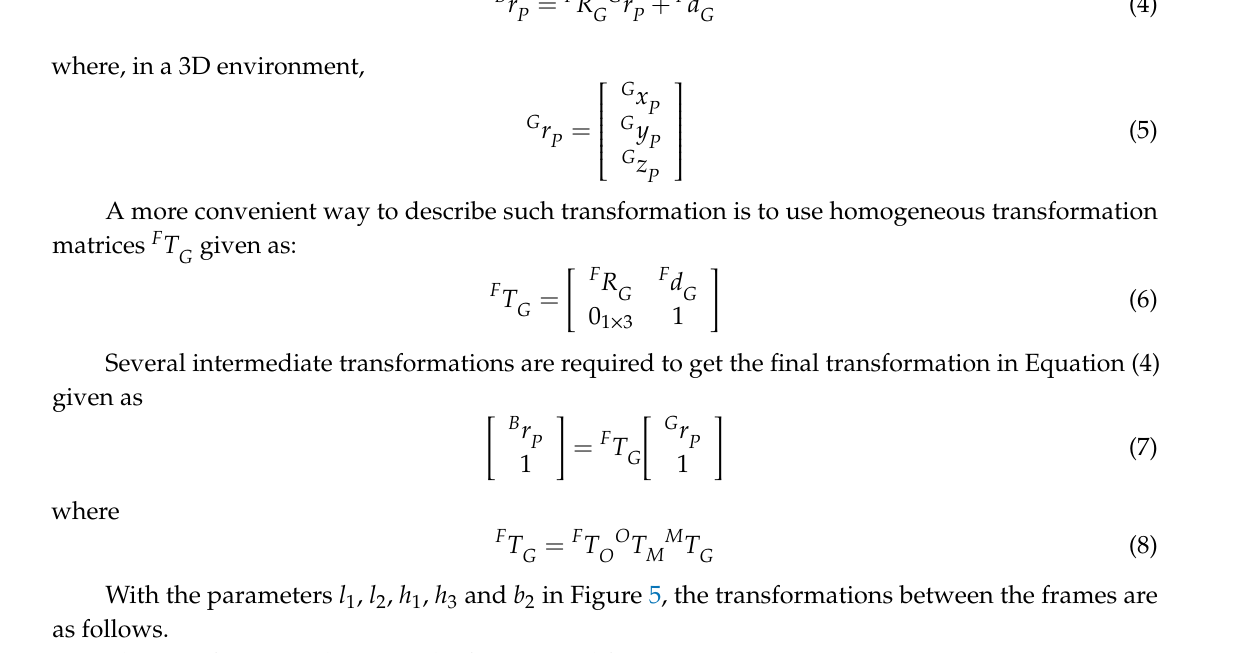
Figure 5. The gimbal in configuration ( θ Y , θ R , θ P ) = (0, 0, 0) viewed from the side and the front with reference frames and relations between them. The direction of each joint is indicated by the dotted line.